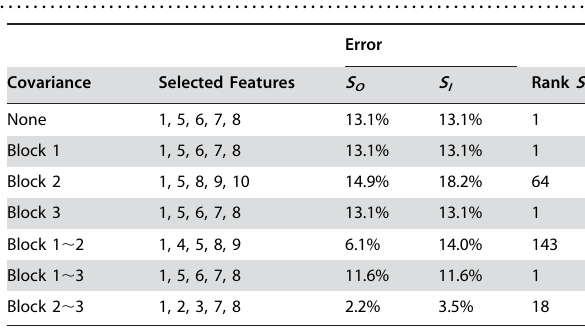
Table 2. The effect of covariance on the optimal